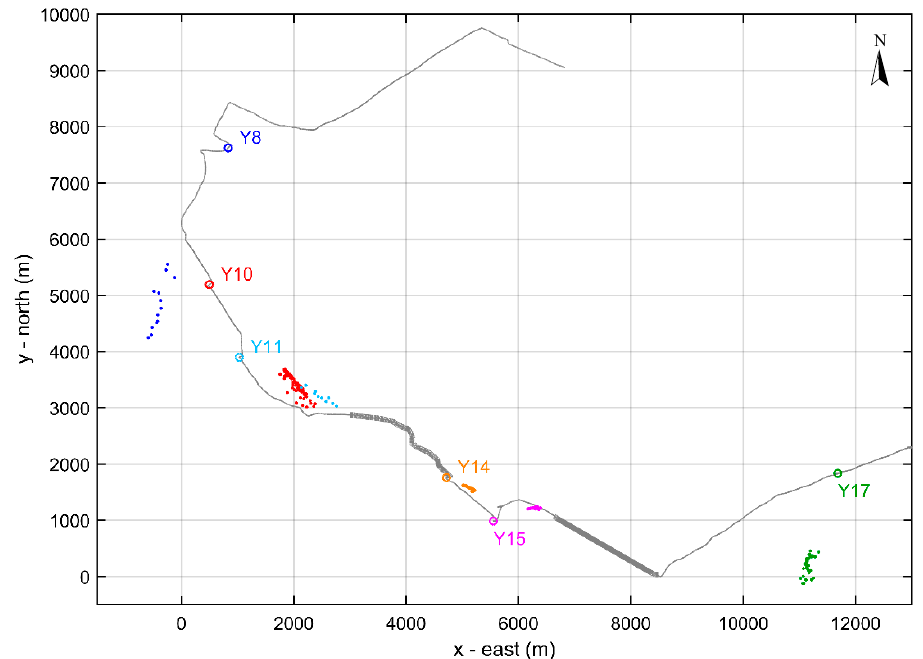
Figure 24. Combination of horizontal localization results for whale Y from all stations. The vessel track (light line) is marked by thicker grey dots when the vessel is next to the whale while at surface in-between two deep dives (between Y11 and Y14 and between Y15 and Y17). The vessel location in the middle of each station is marked by a circle of different color—the same color is used for the corresponding localization results of the sperm whale (color dots).